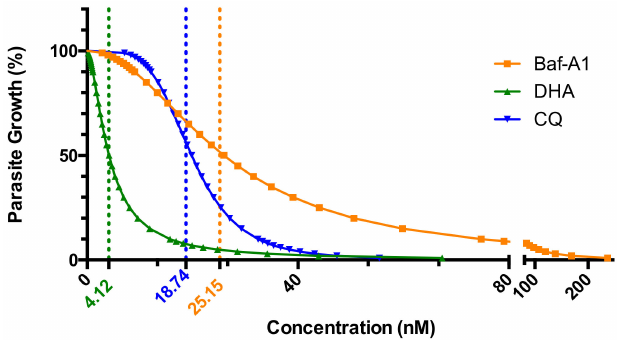
Figure 2. Survival curves of P. f 3D7 treated with Baf-A1 and anti-malarial drugs CQ / DHA. Data was obtained from three independent triplicate experiments. Their IC 50 values were shown in dotted